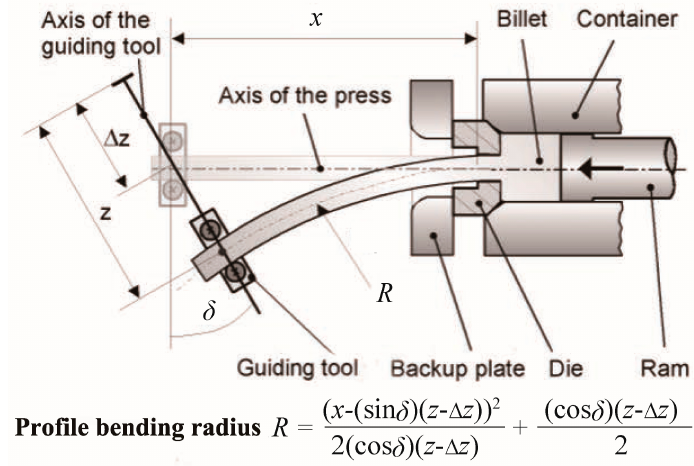
Figure 19. Process principle of curved profile extrusion (CPE) [75,76].